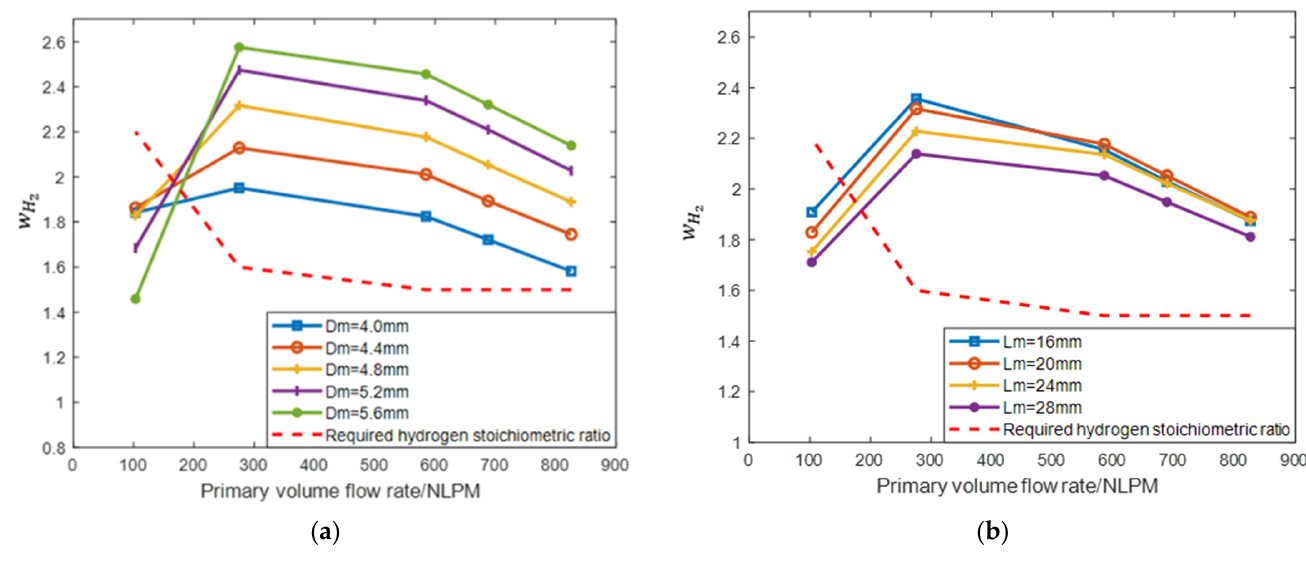
Figure 6. Entrainment ratio at different geometric parameters: ( a ) hydrogen entrainment capabil- ity at various Dm with Dn = 1.32 mm; ( b ) hydrogen entrainment capability at different Lm with Dn = 1.32 mm, Dm = 4.8 mm, NXP = 3